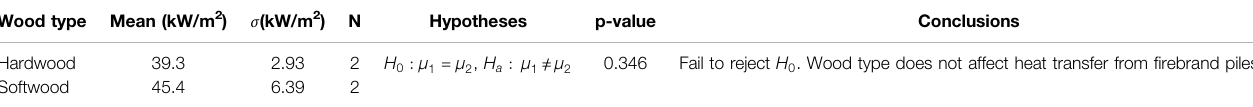
TABLE 8 | Summary of the statistical analysis of the effect of fi rebrand wood type on the heat transfer from fi rebrand piles. Wood type Mean (kW/m 2 ) σ (kW/m 2 ) N